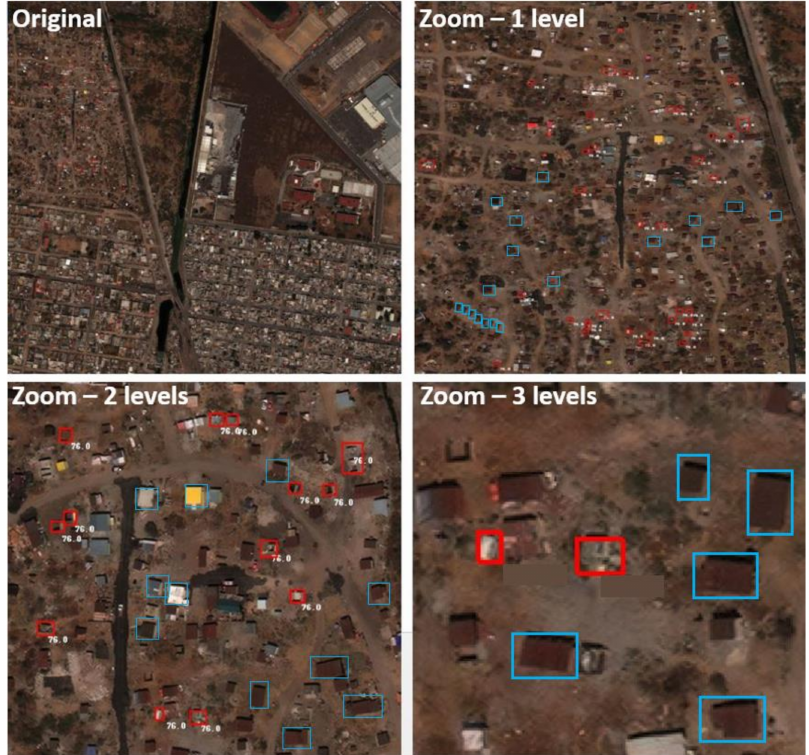
Figure 1. One satellite imagery scene from the xView dataset with demolished buildings shown in red boxes and intact buildings in blue boxes. The image scene is shown at three zoom